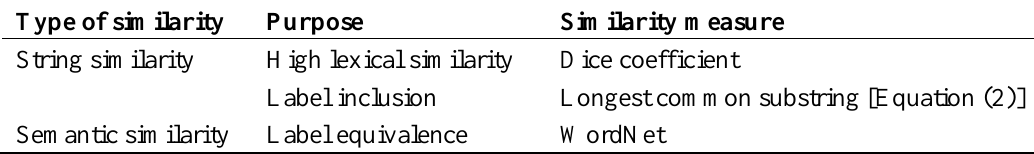
Table 1. Used matching